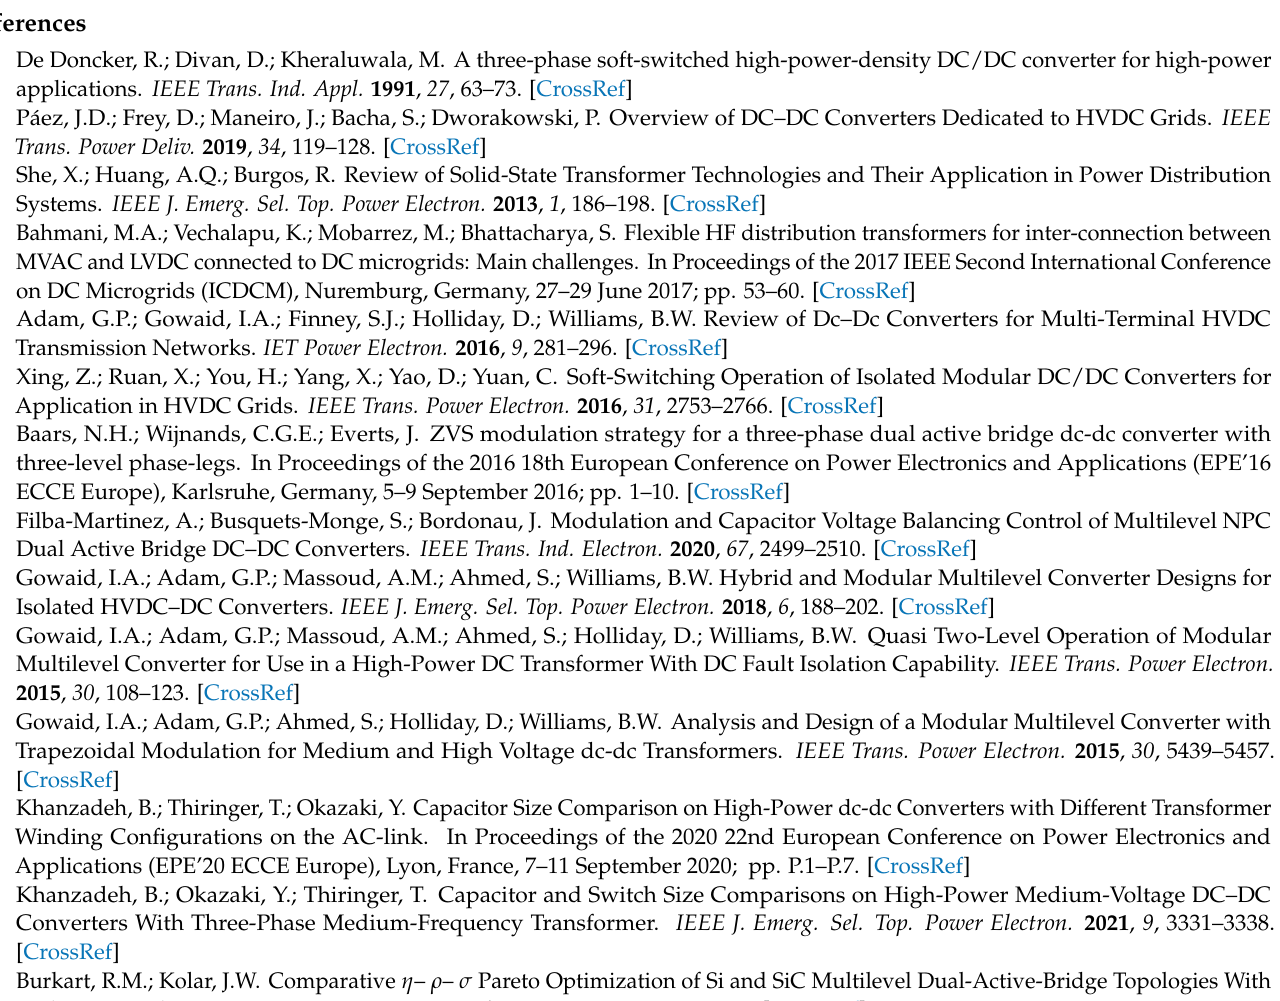
Figure A1. The phase currents of the MFT on the points P i , i ∈ { 1,2,3,4 } as a function of the leakage inductance. The dashed green curve shows the maximum of the currents on the operation